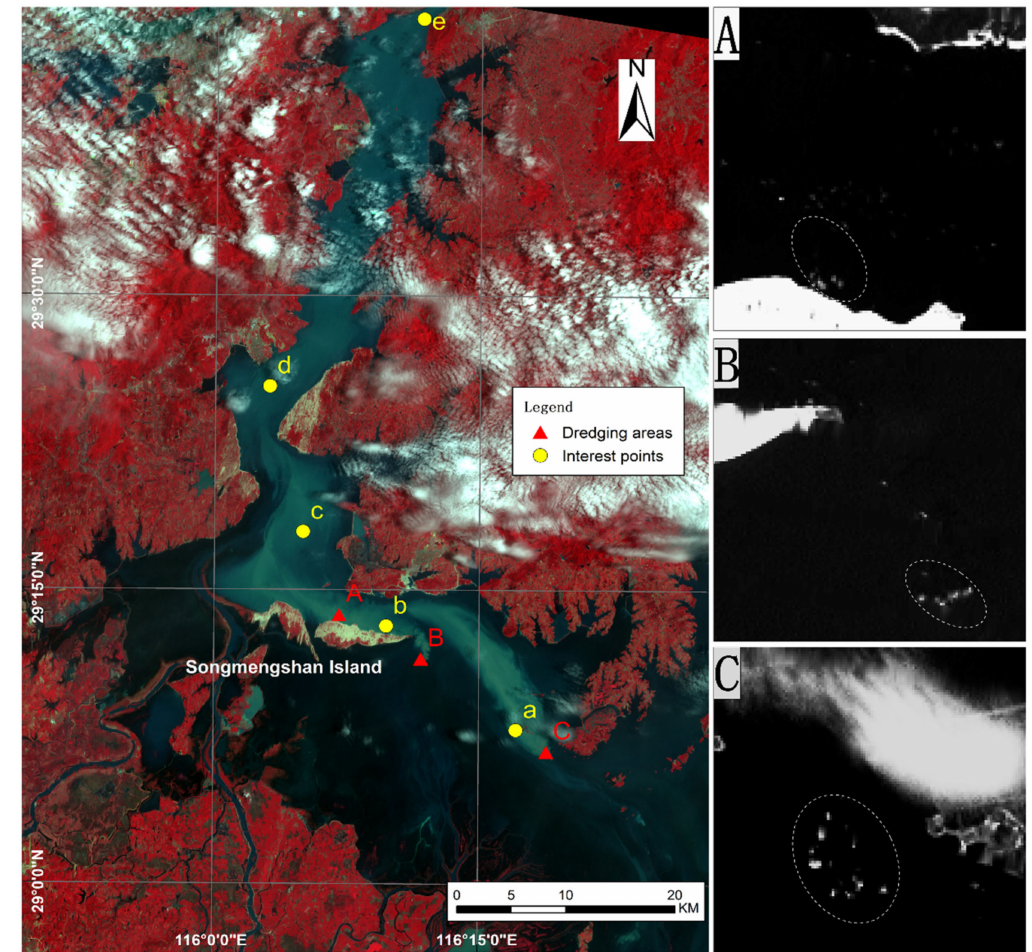
Figure 3. Three main sand dredging areas (A, B, and C in the subfigure) and five points of interest (POIs a, b, c, d, and e) in Poyang Lake on Landsat ETM + images composed by Band 4, 3, and 2, acquired on July 4, 2011, and zoomed-in for the main dredging areas A, B, and C on Band 7, which is sensitive to dredging